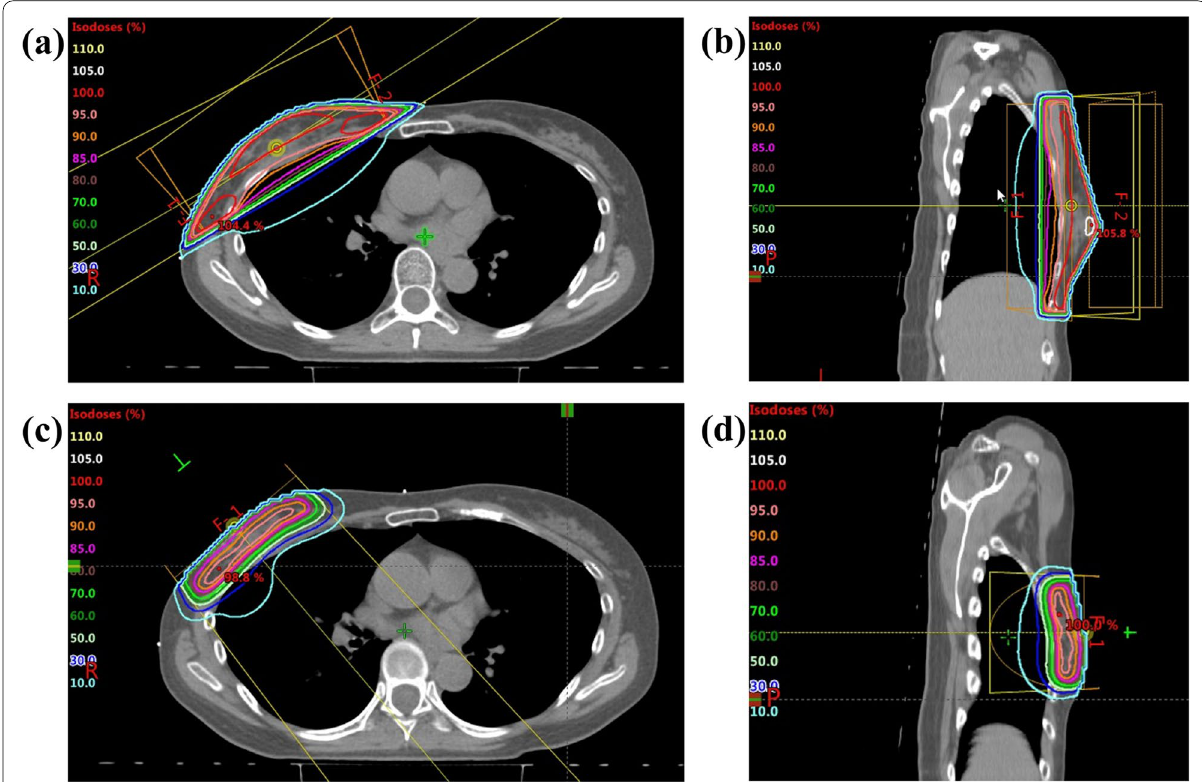
Fig. 1 Radiotherapy fields. Axial ( a ) and sagittal ( b ) images of whole breast irradiation. Axial ( c ) and sagittal ( d ) images of tumor bed irradiation. Whole breast irradiation was performed at 2 Gy 25 times. Tumor bed irradiation was rescheduled from 5 times at 2 Gy to 4 times at 2.5 Gy due to